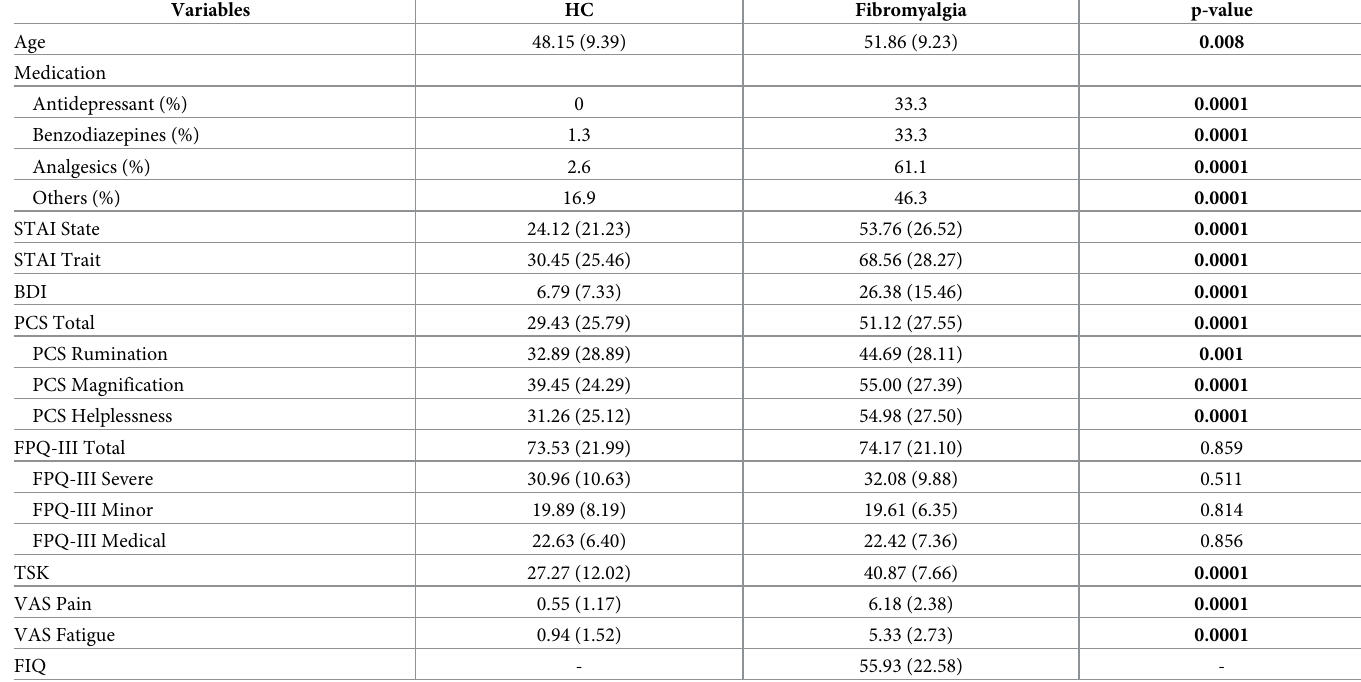
Table 2. Mean and standard deviations of age, level of anxiety, depression, pain catastrophizing, fear of pain, fear of movement, pain and fatigue. Information about the percentage of participants (healthy controls and patients) who were taking medications is also included.